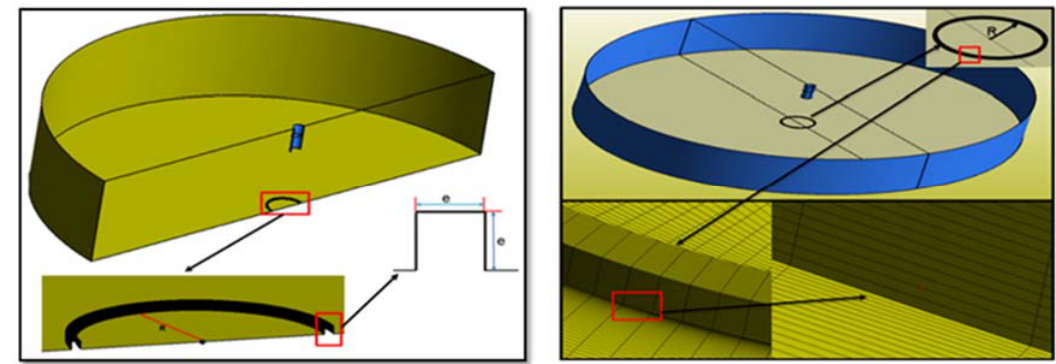
Figure 3. Geometry and meshing of circular rib of radius R, with a square cross-section of length e.